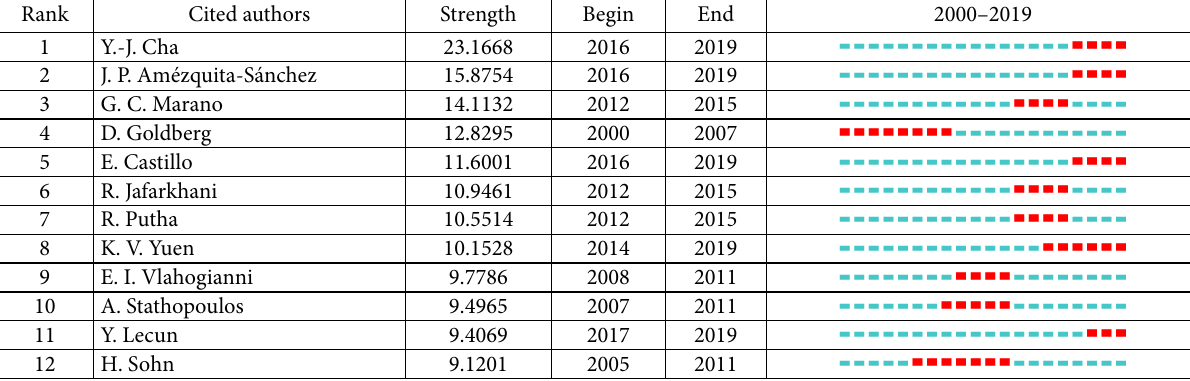
Table 4. The top 12 strongest cited authors in the CACAIE from 2000 to